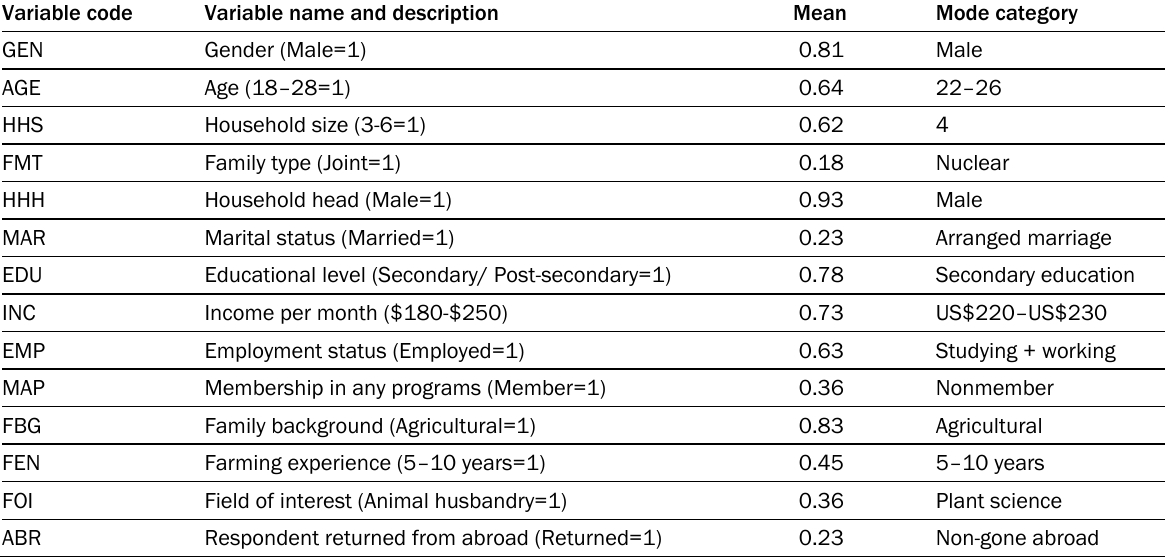
Table 2. Socioeconomic Characteristics of the Study